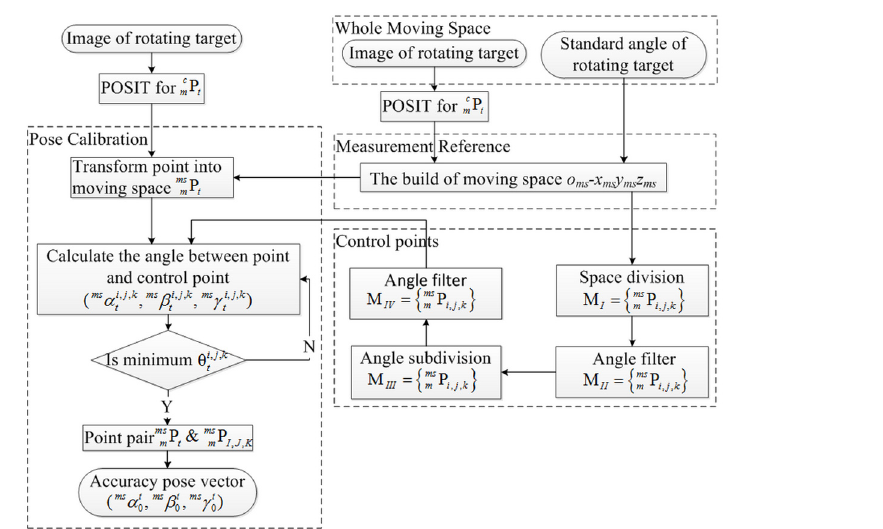
Fig 8. Measurement flowchart.